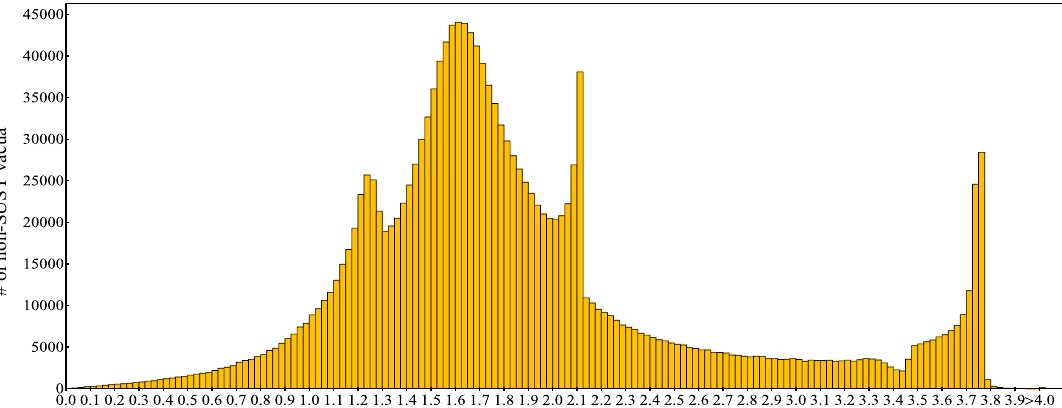
Figure 2 . The distributions of All vacua satisfy the BF bound. Here, we set the increments to be 0.025 to clarify the fine structure of the